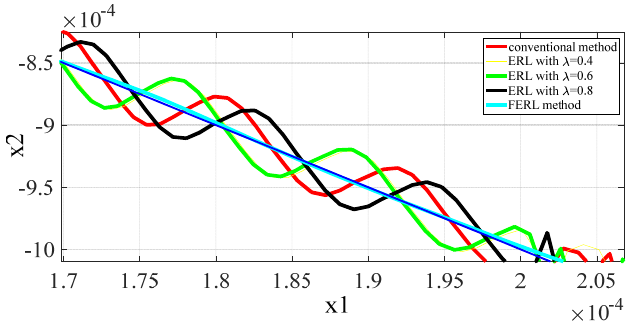
Figure 3. Amplified figure of the trajectories near the switching surface.